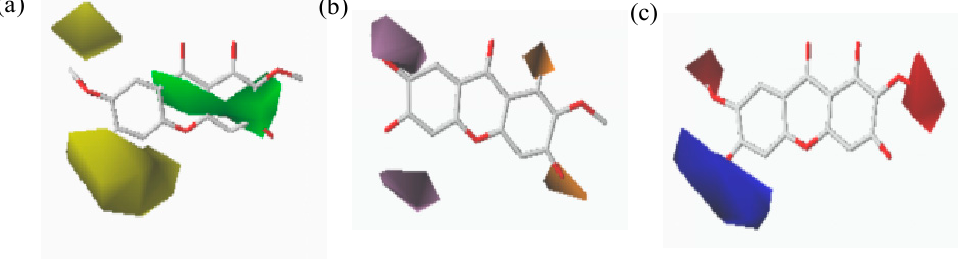
Figure 5. Contour maps of CoMSIA: steric ( a ); electrostatic ( b ); and hydrophobic ( c ) based on Compound 3 .